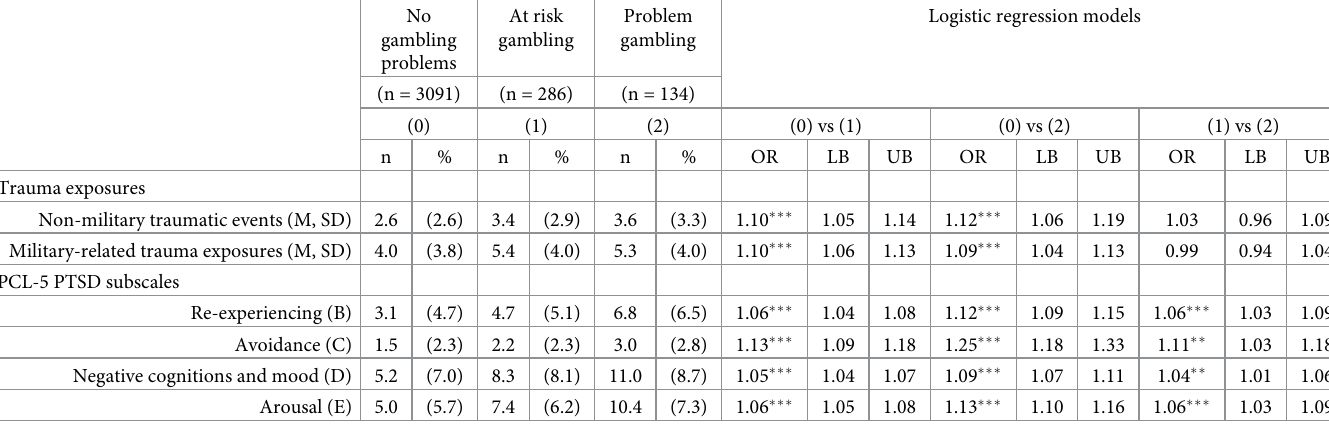
Table 4. Multinomial logistic regression models indicating PTSD and trauma as predictors of gambling problems.